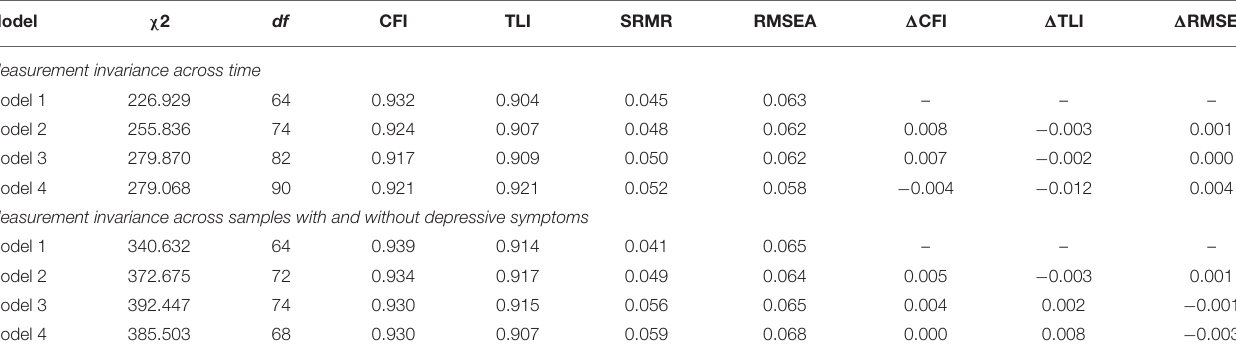
TABLE 7 | Measurement invariance of the RRS-10 across time and across samples with and without depressive symptoms. Model Measurement invariance across time